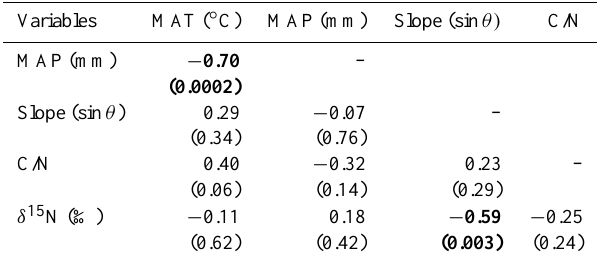
Table 2. Correlation matrix (Pearson) for Pinus morrisonicola and Cymbopogon sp. ( n = 23) from the Central Range, Taiwan. Val- ues in bold italic are different from 0 with a significance level of α = 0.05; P values are given in